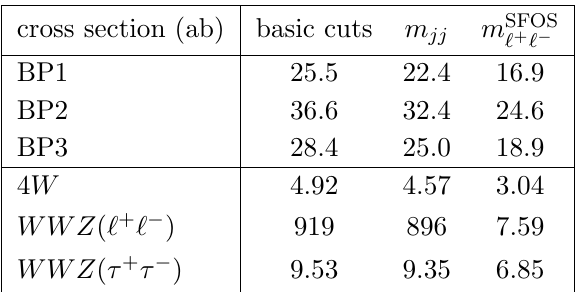
(cid:20) (cid:20) and measurements at the HL-LHC as shown in W Z j j j j